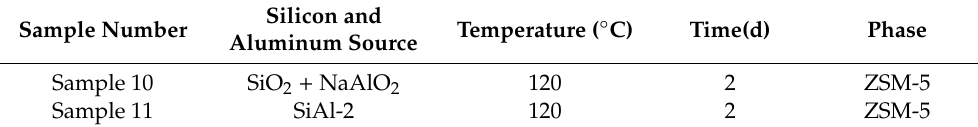
Table 3. The reaction conditions and phases of Samples 10 and 11.